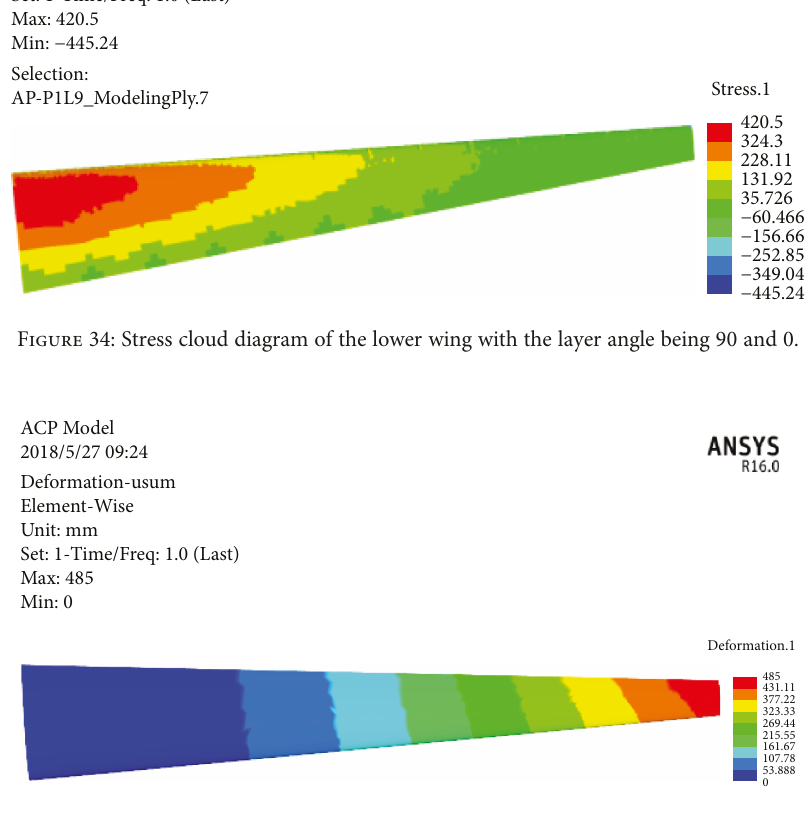
Figure 35: Deformation cloud diagram with the layer angle being 45 and 90.